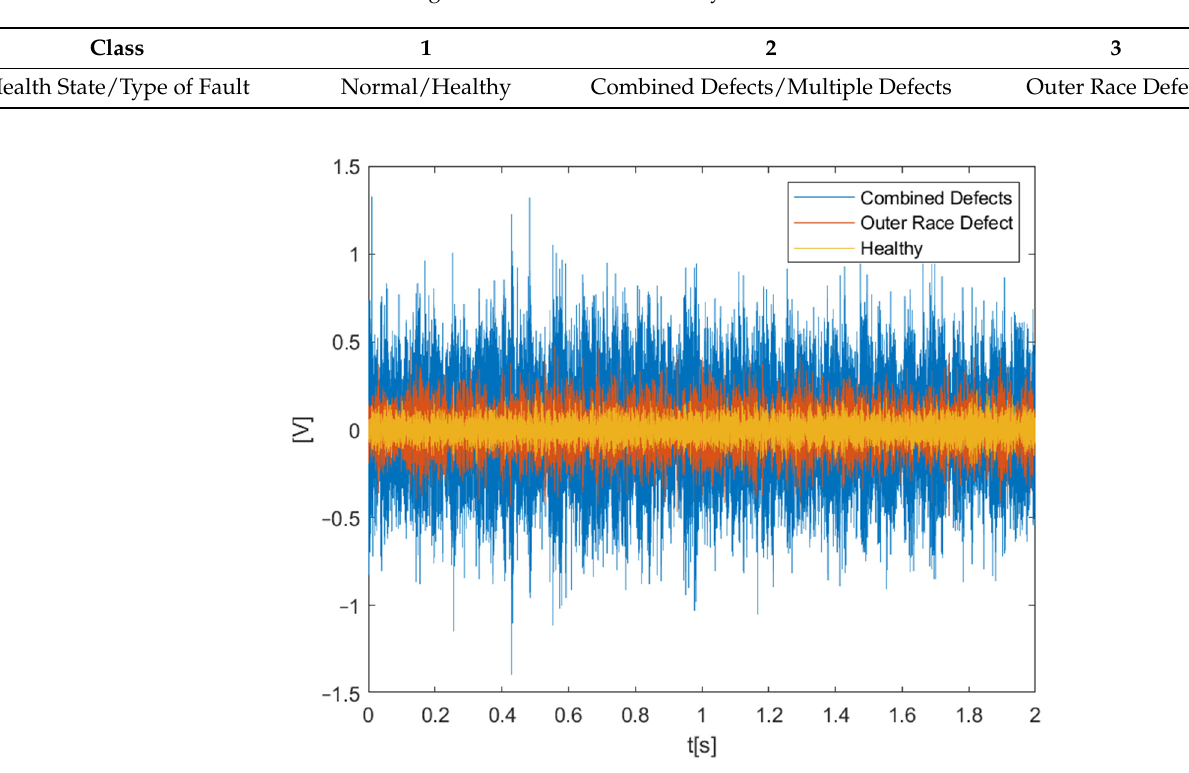
Table 3. Different operating conditions considered in case study-2.